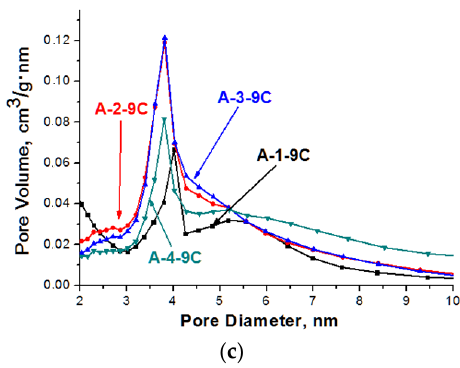
Figure 1. Values of S BET ( a ); pore size distribution of samples A-1, A-2, A-3-Na, and A-4-K ( b ); and A-1-9C, A-2-9C, A-3-Na-9C, and A-4-K-9C ( c ). Table 2. Texture characteristics, the crush strength values, and modifications to the content of additives in the alumina samples before and after pressure